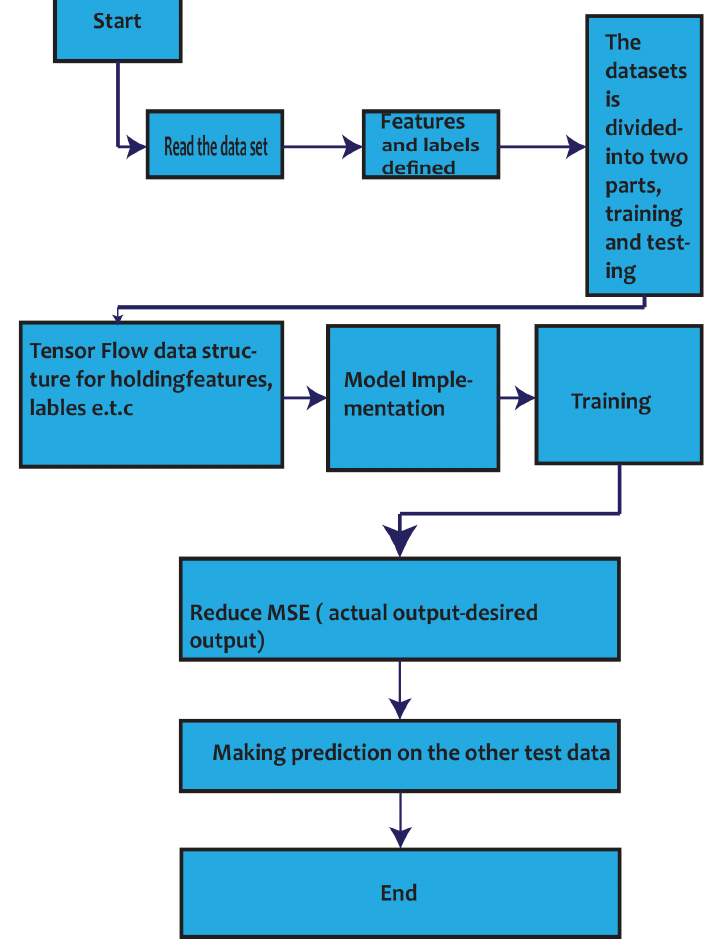
Figure 4. Flow diagram for the implementation of the use case.